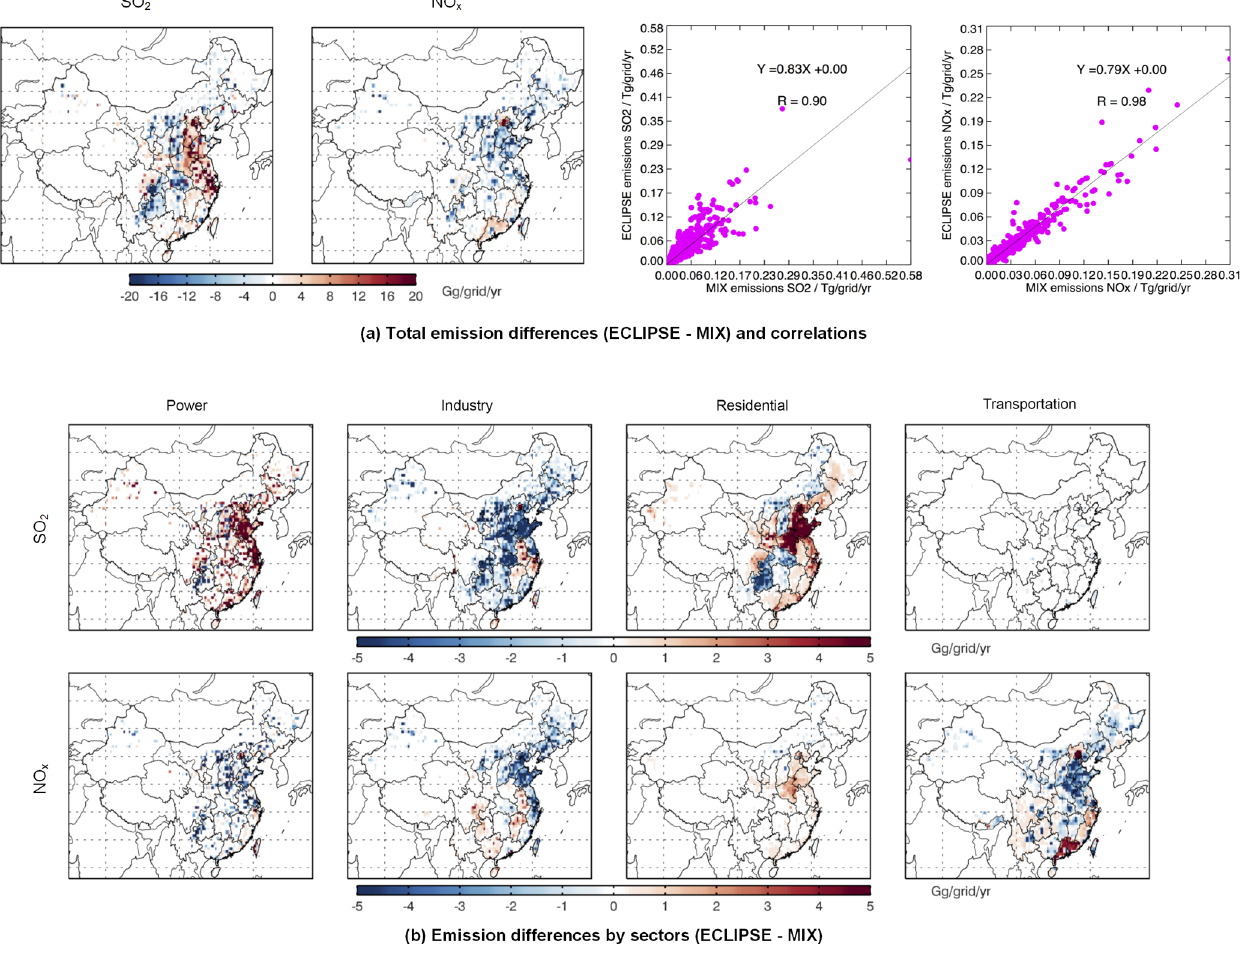
Figure 3. Comparisons of MIX and ECLIPSE gridded emissions on 0 . 5 ◦ × 0 . 5 ◦ grids for